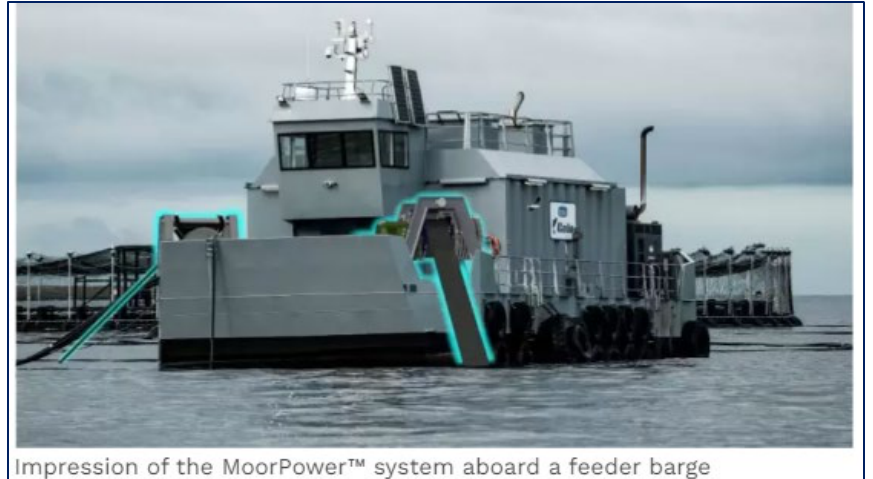
Figure 27. Moorpower TM floating feed barge showing wave energy converters in green—image from https://blueeconomycrc.com.au/project/moorpower-scaled-demonstrator/ (accessed on 22 September 2022).